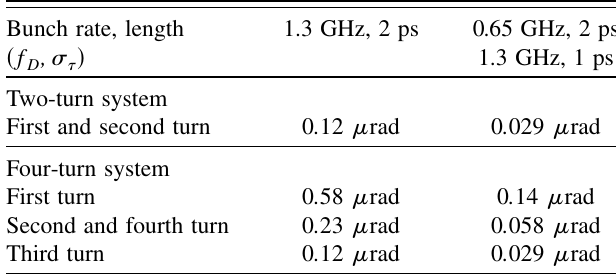
TABLE II. Angular spread (cid:4) by multiturn circulation system (cid:1) for bunch rates 1.3 and 0.65 GHz and for bunch lengths 2 and 1 ps with parameters in Table